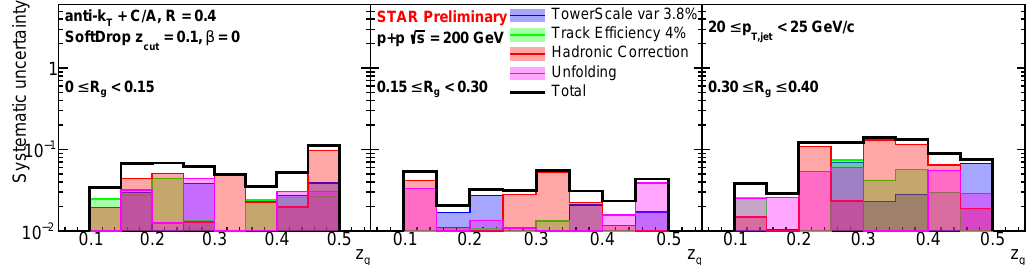
Figure 1: Systematic uncertainties for z < p < 25 GeV / c T,jet